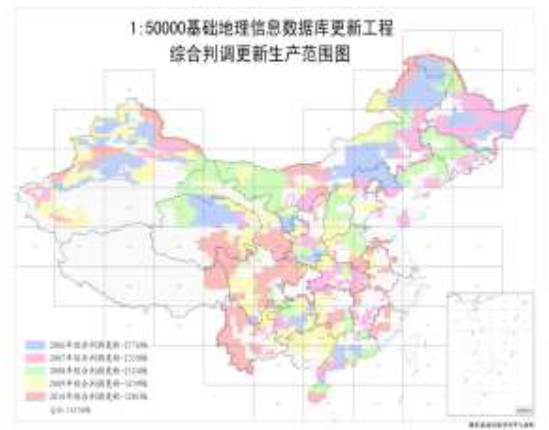
Figure 8. The coverage of 1:50000 DLG updating based on imagery interpretation